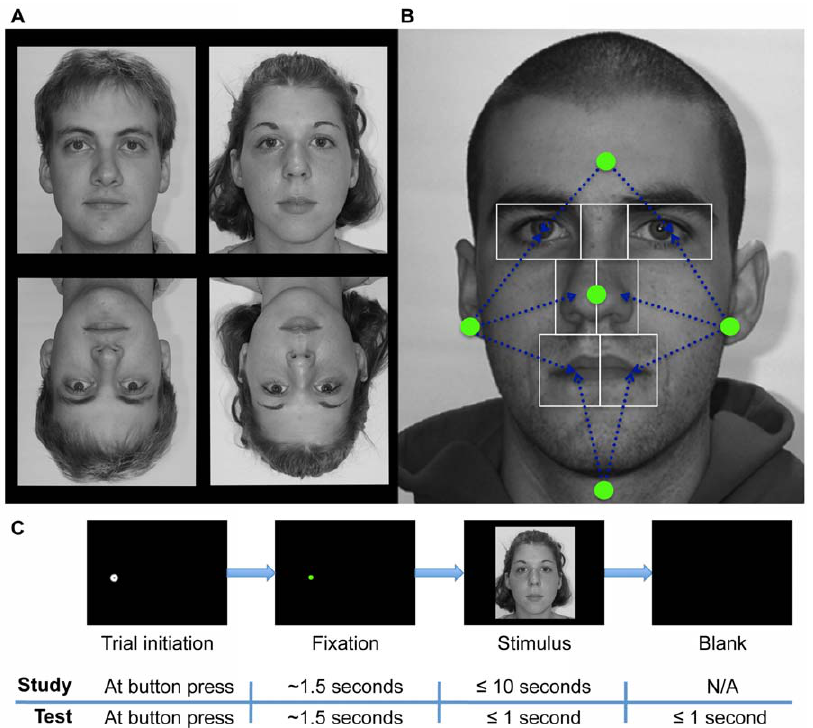
Figure 1. Study design. ( a ) Four example stimuli. Note that all faces were aligned to one another and scaled to be the same size. ( b ) Calculation of start positions. Start positions were determined separately for each face and were defined relative to the face. Left and right start positions were equidistant from centers of the nearest eye, nose and mouth AOIs. Upper and lower start positions were equidistant from the centers of the two eye or two mouth AOIs, respectively. ( c ) Trial sequences in study and test phases. A face was only presented if the participant successfully maintained fixation for a total of 1.5 seconds. After face onset in the study phase, participants were free to study the face for up to 10 seconds and pressed a button to begin the next trial. In the test phase, faces were presented for one second only and participants responded with button presses to indicate whether the face was ‘old’ or ‘new’.